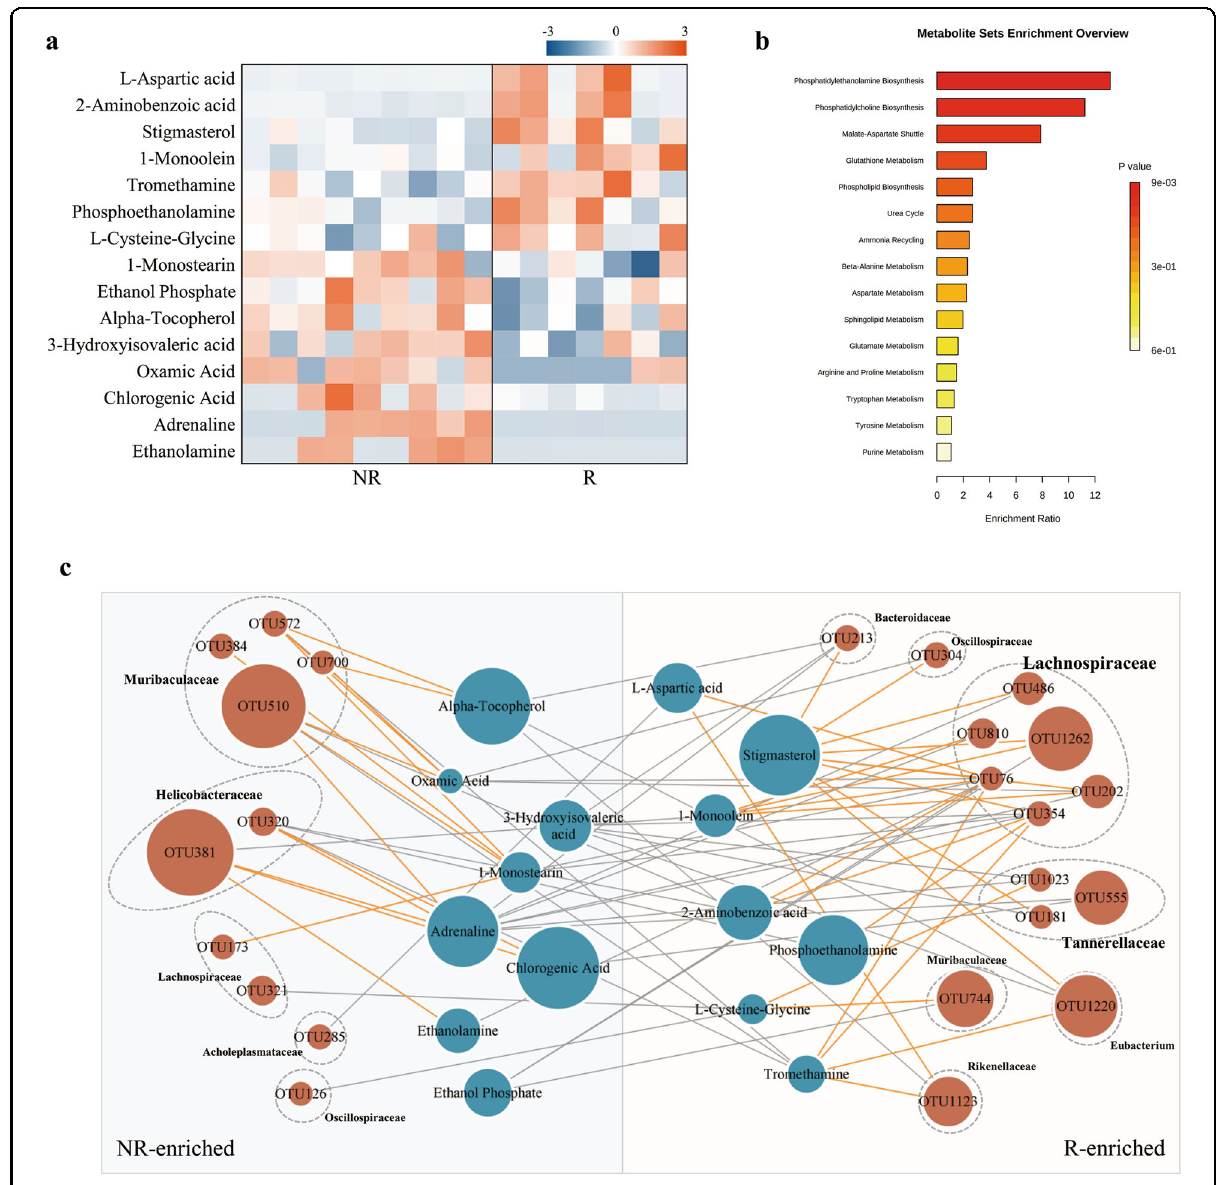
Fig. 5 Metabolomic analysis for serum samples in R and NR groups. a Heat map based on differentially abundant metabolites between R and NR groups determined by LEfSe analysis LDA > 2 and p < 0.05, 7 and 8 metabolites were enriched in R and NR group, respectively. b Pathway enrichment analysis of differential abundant metabolites, the phosphatidylethanolamine biosynthesis is the predominant metabolic pathway. c Interaction networks among signi fi cant OTUs and metabolites, size of node indicates abundance, different colors of nodes represent metabolites (blue) and OTUs (orange), negative correlations are colored in lines of grey and positive correlations are shown in lines of orange, thickness of the lines re fl ects the strength of the correlation (Spearman correlations with rho > 0.5, p <